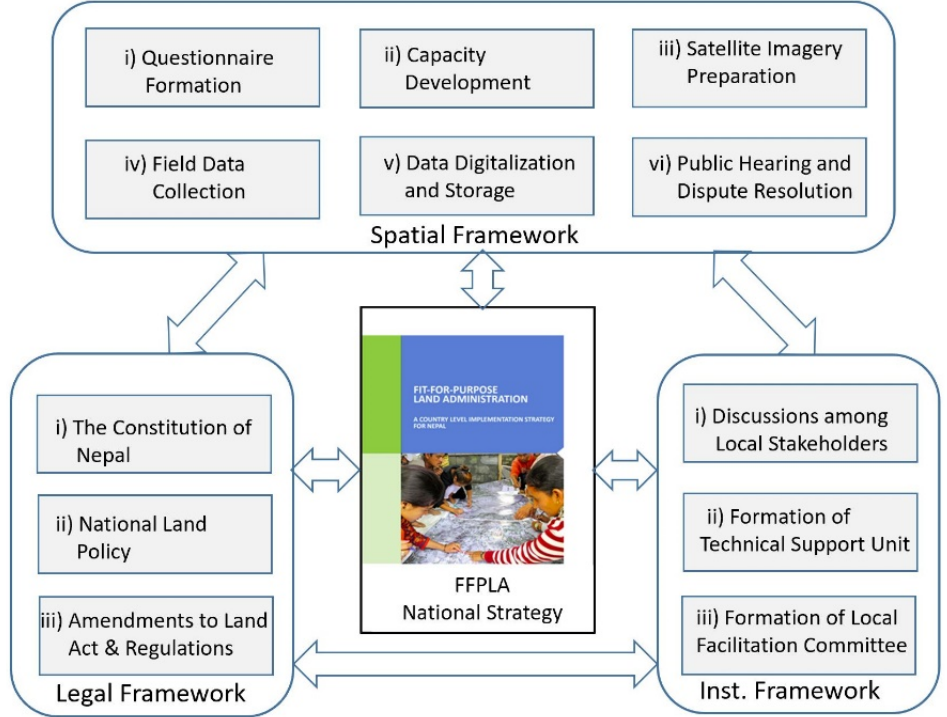
Figure 2. Overall methodological workflow of the research.